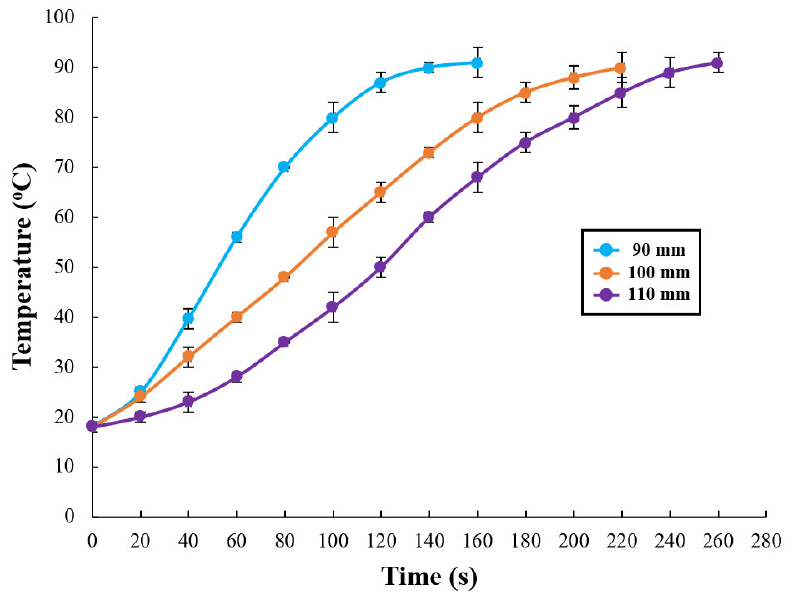
Figure 1. Temperature–time curve of RF heating of PME solution with three different electrode gaps.